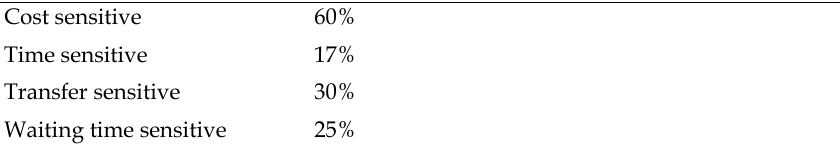
Table 8. Percentage of respondents that based their decision on the segment-specific prominent